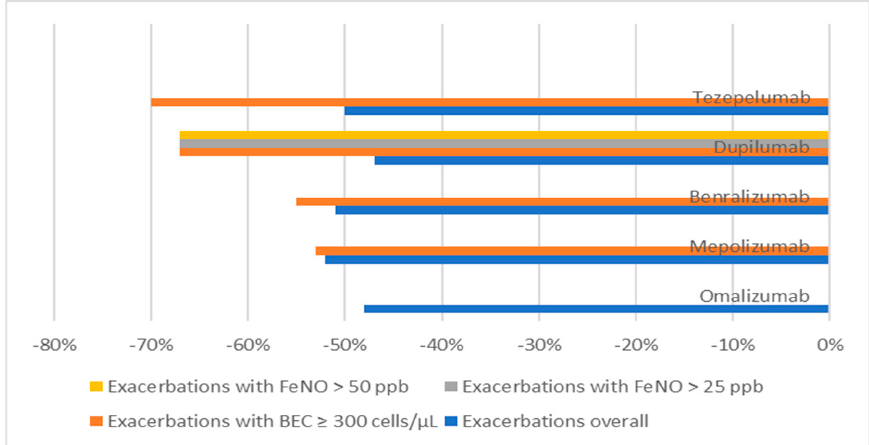
Figure 2. Exacerbations based on biomarkers. FENO: fractional exhaled nitric oxide; BEC: blood eosinophil count.